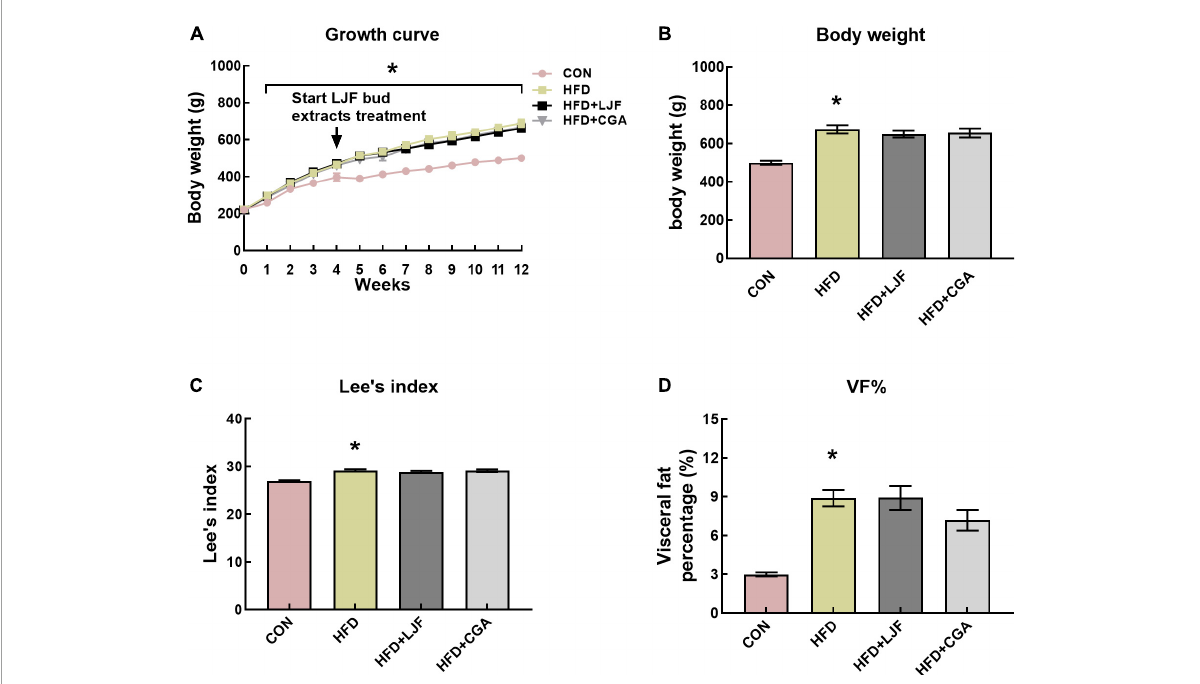
FIGURE1 Lonicerae Japonicae Flos (LJF) and chlorogenic acid (CGA) have no significant effect on body weight and VF% in prediabetes rats. (A) Graph showing evolution of body weight in male SD rats fed a standard diet vs. HFD diet for up to 12 weeks. (B–D) Body weights, Lee’s index, and VF% (visceral fat mass as a percentage of body weight) at the end of the study. Data are expressed as means ± SEM ( n = 8 per group). * P < 0.05, HFD group vs. CON group.